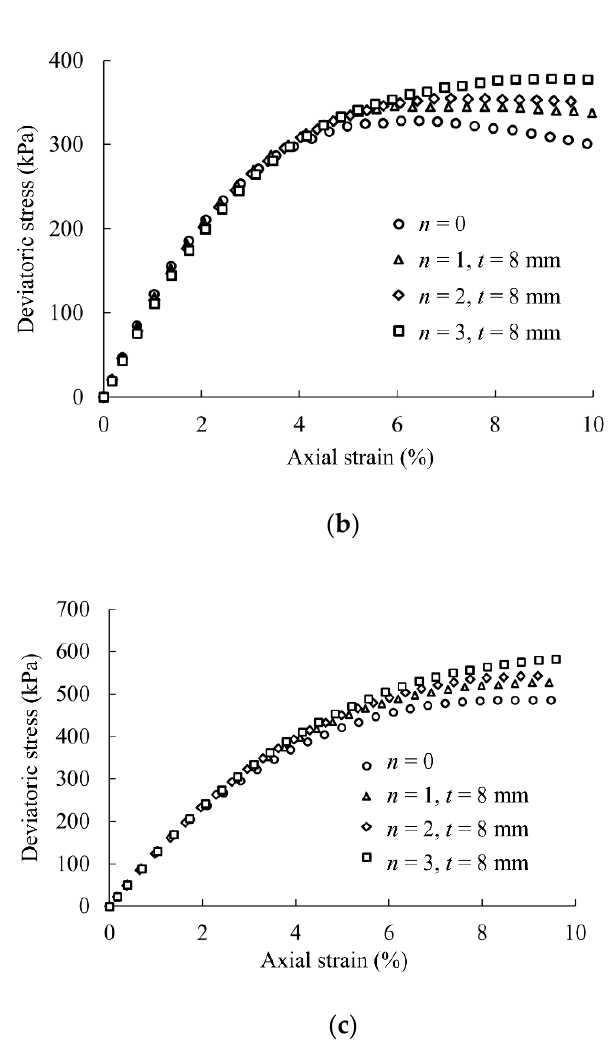
Figure 7. The deviatoric stress–axial strain curves of the SCL samples with different numbers of sand layers and confining pressures of ( a ) 150 kPa, ( b ) 250 kPa, and ( c ) 400 kPa.